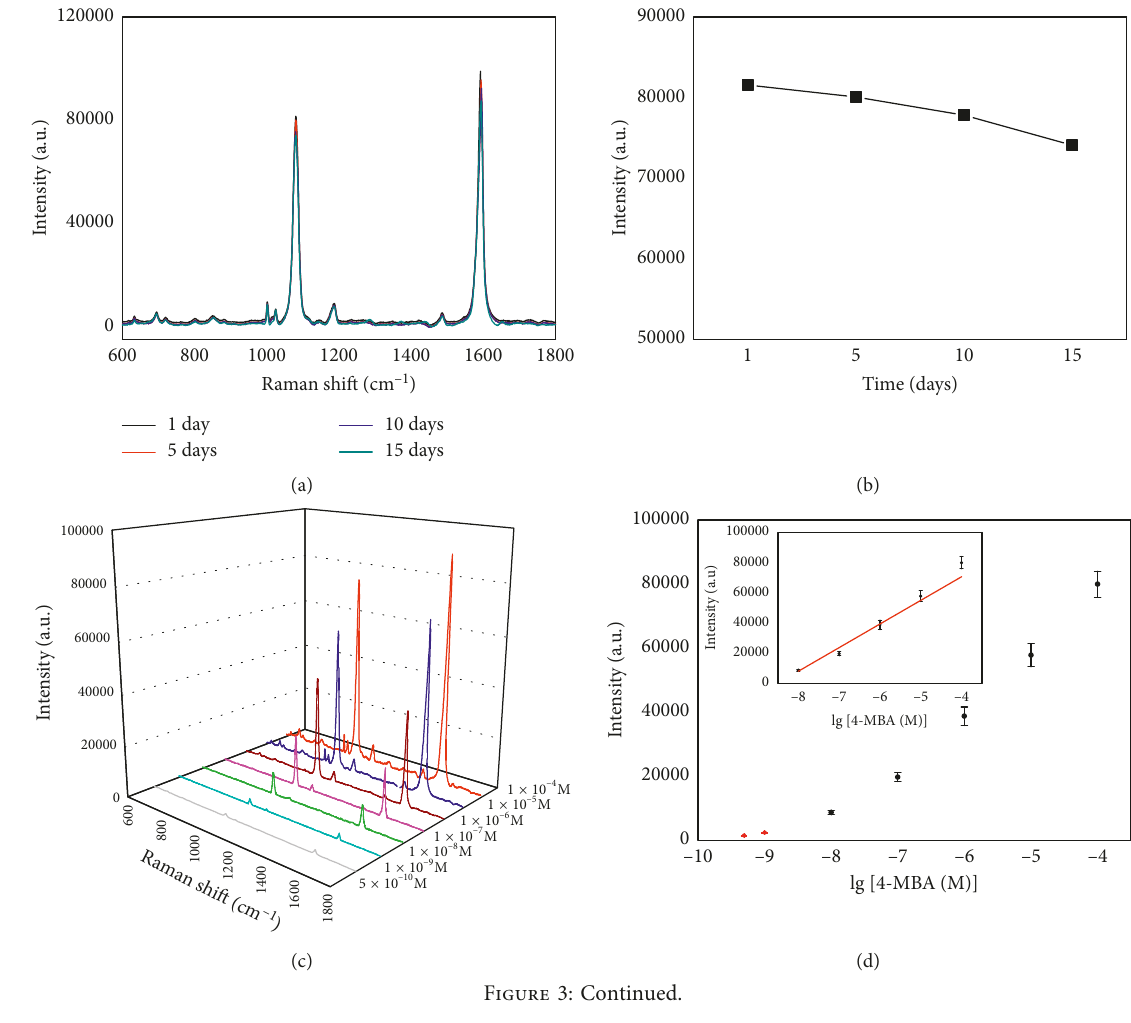
Figure 2: (a) SEM images of the HGNPs substrate. (b) SERS mapping of 4-MBA measured at 1080cm acquisition time was 10s, and the laser power was